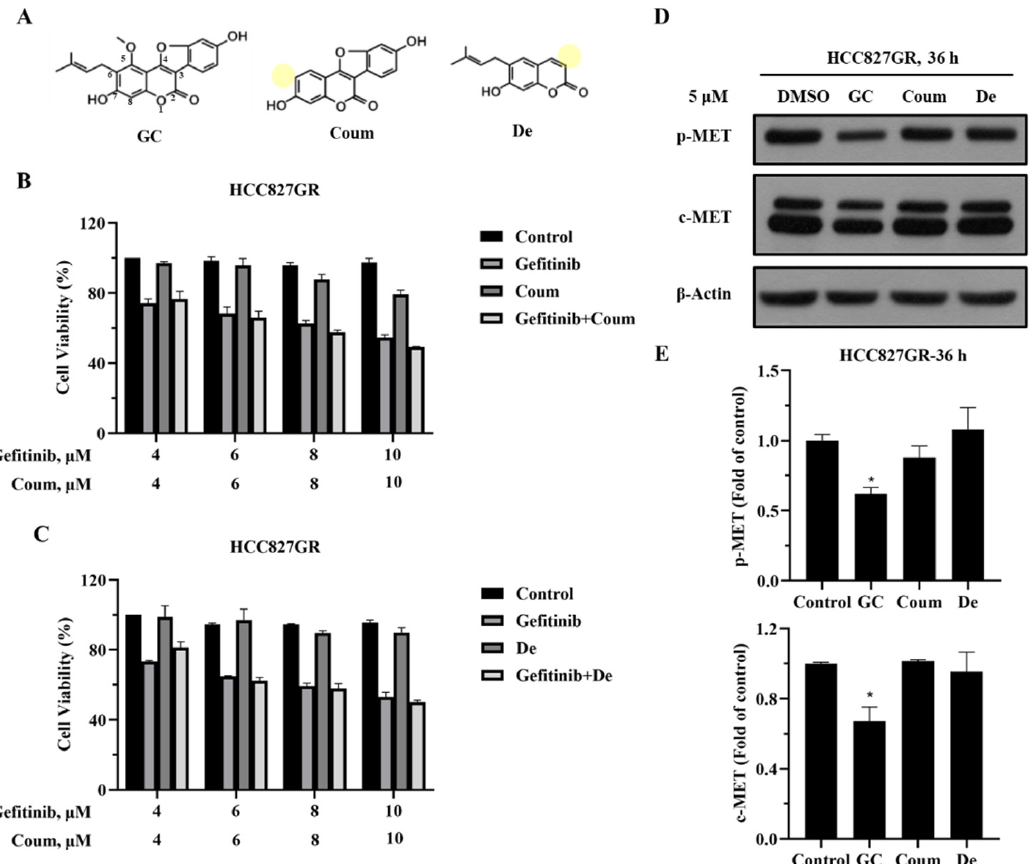
Figure 4. Both the benzofuranyl group at c-3/4 and the isopentenyl group at c-6 are indispensable for glycyrol to exert the sensitization effect. ( A ) Chemical structure of glycyrol and its analogues, demethylsuberosin and coumestrol. ( B ) The changes of cell viability in response to gefitinib, demethylsuberosin, or their combination. ( C ) The changes of cell viability in response to gefitinib, coumestrol, or their combination. ( D , E ) Influence of glycyrol and its analogues demethylsuberosin and coumestrol on MET activation. * p < 0.05